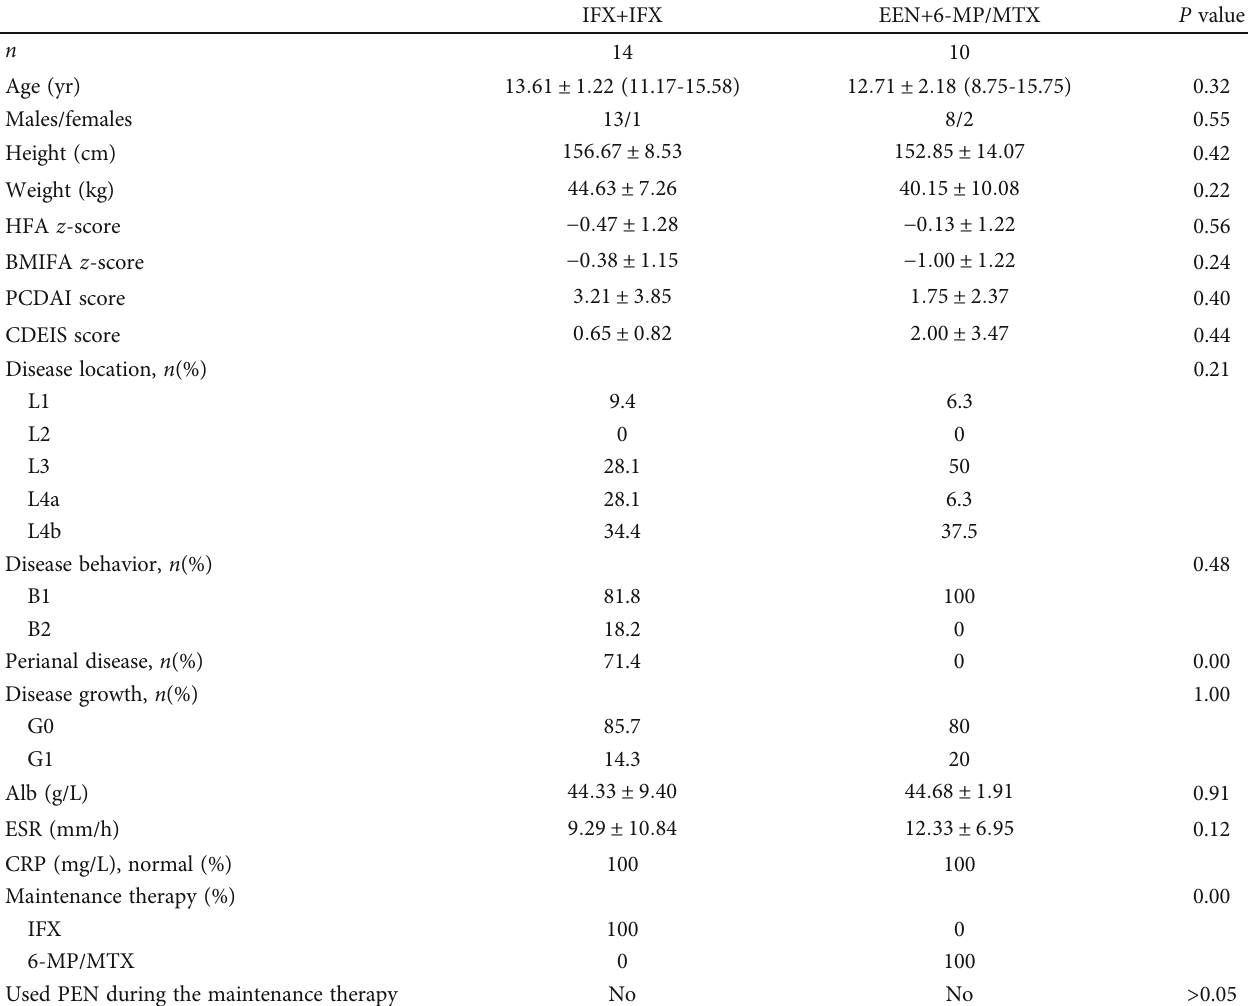
Table 2: Demographic and clinical characteristics of enrolled patients at the beginning of maintenance